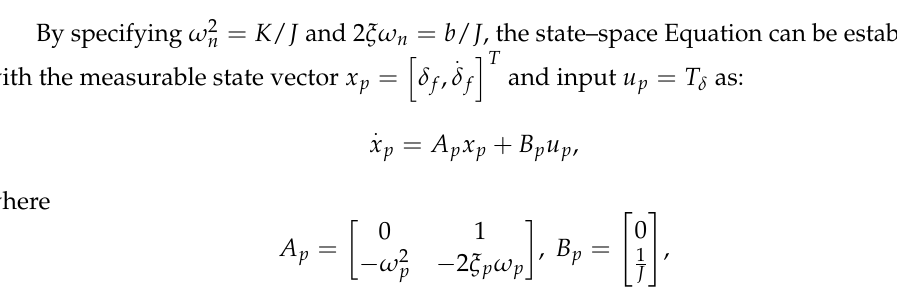
Figure 4. Active front wheel steering system.